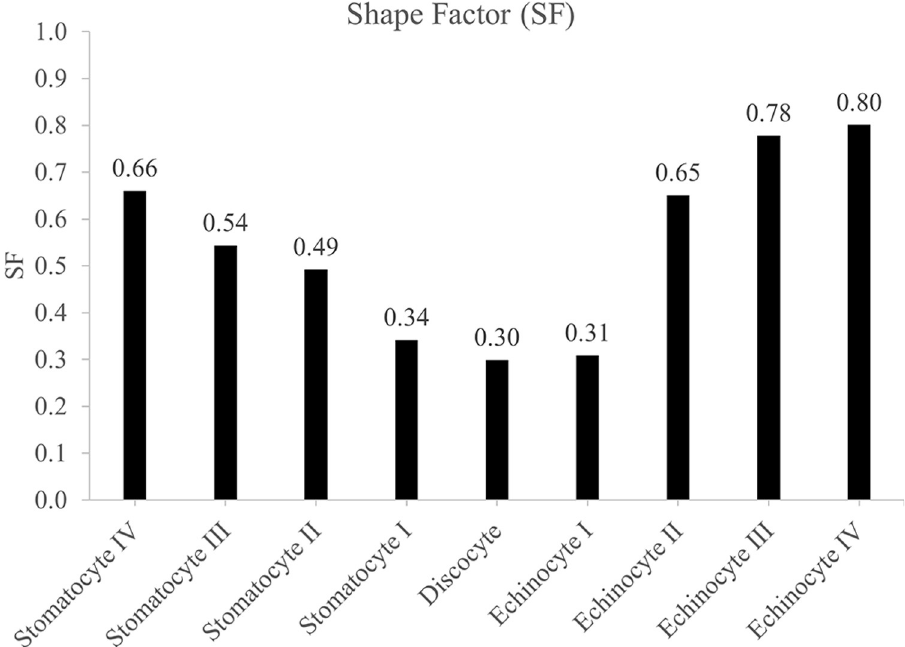
Fig 8. Shape Factor SF ð Þ for CG-RBC membrane model predicted stomatocyte IV—echinocyte IV RBC shapes.